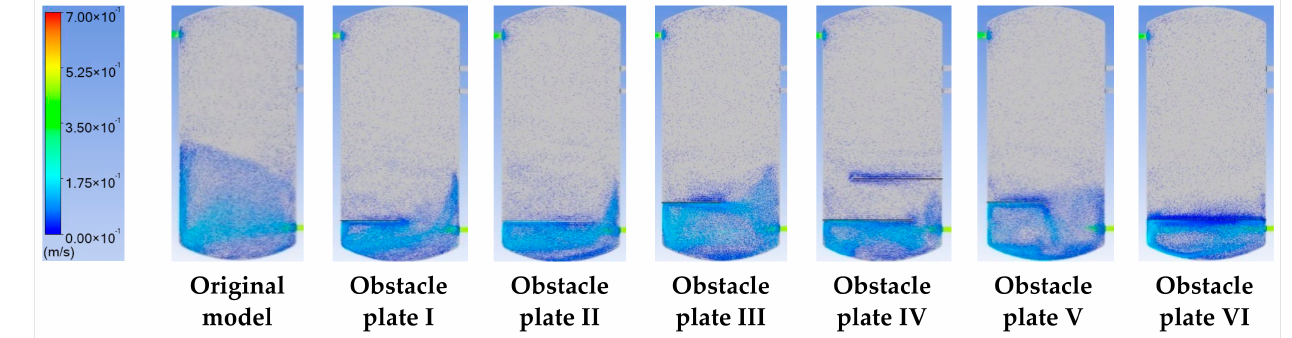
Figure 22. The velocity profiles of the obstacle plate